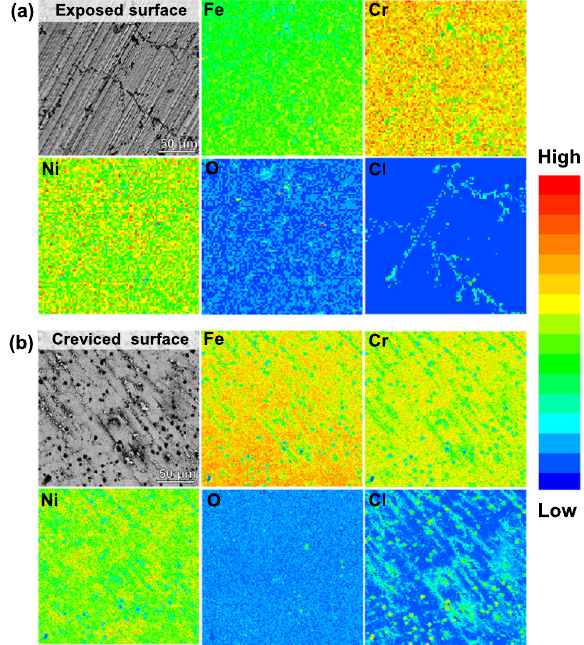
Fig. 3 EPMA elemental distribution on the surface of the 304SS steel fastener. a Exposed region, b crevice